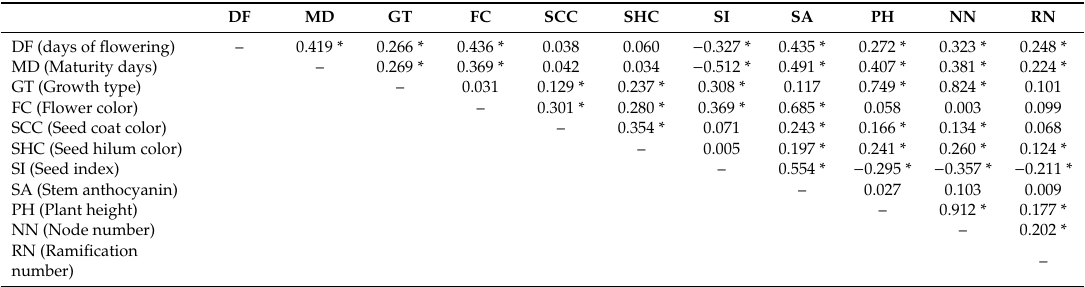
Table 3. Matrix of correlation coe ffi cients between 11 agronomic traits in 208 soybean MDP lines.